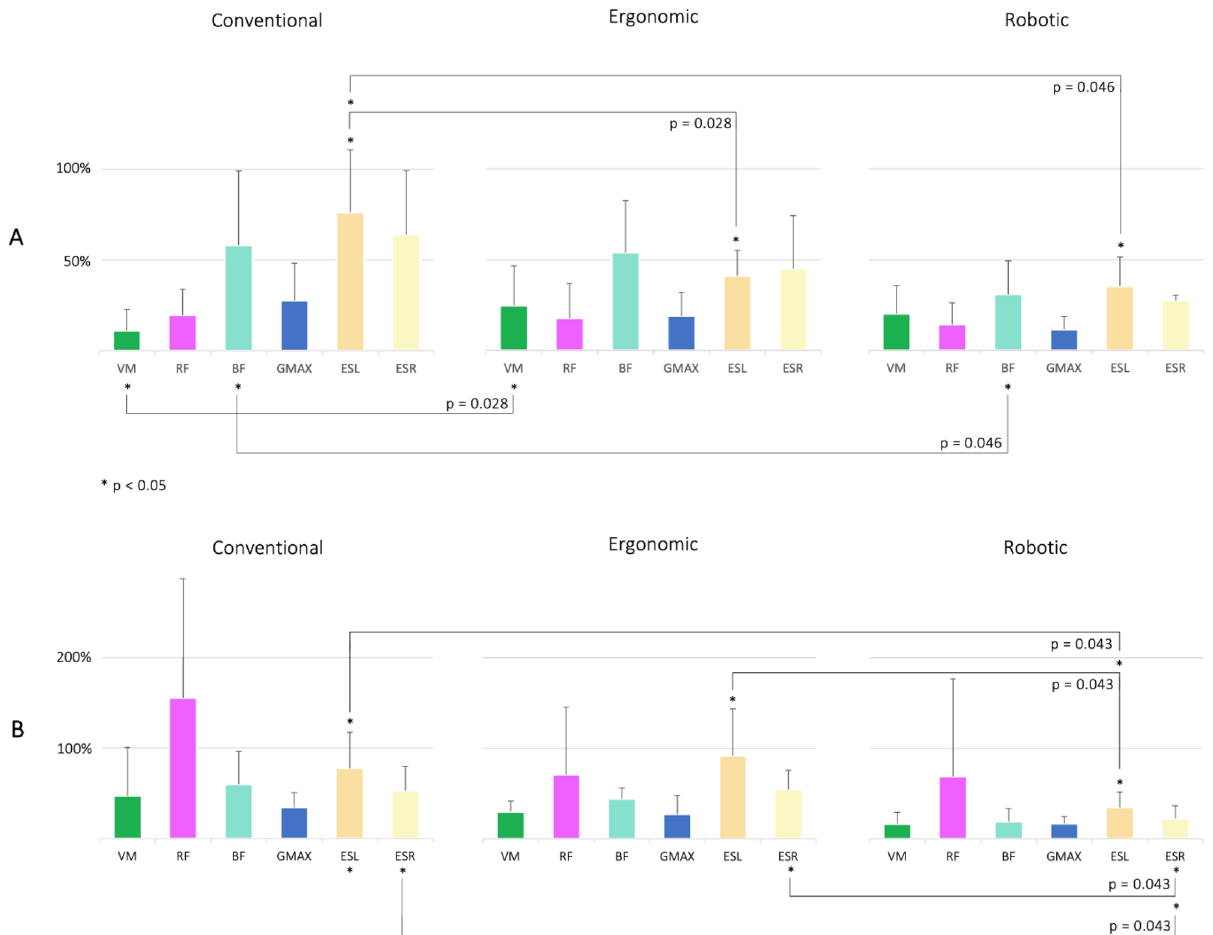
Figure 7. Mean muscle activity data of vastus medialis (VM), rectus femoris (RF), biceps femoris (BF), gluteus maximus (GM), left erector spinae (ESL), and right erector spinae (ESR) normalized by the muscles’ peak RMS amplitude recorded during STS performance (see Methods and Supplementary Material, Fig. 2). The results are presented with significant comparisons of the two-sided Wilcoxon signed rank test for each group and each of the manual patient handling tasks conducted (see Supplementary Material, Table